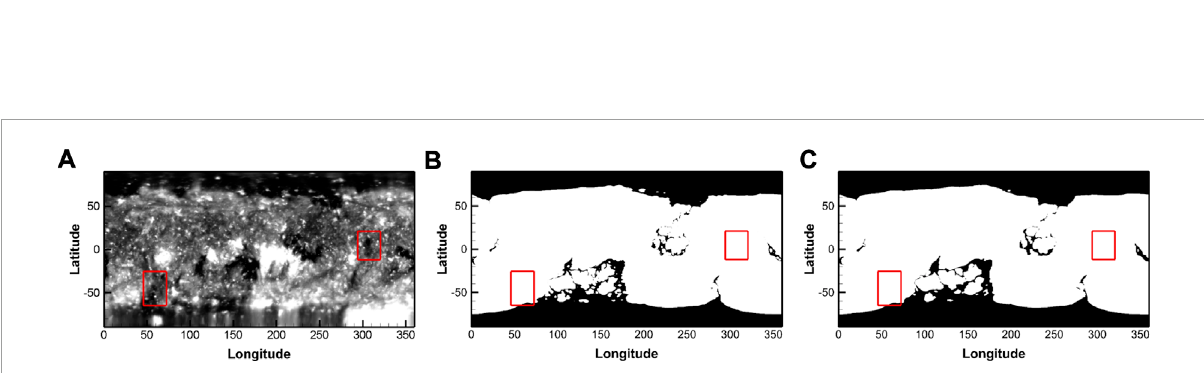
FIGURE 5 Radial magnetic field (Unit: G) at 1 . 8 R s for SHE (black lines), FDIPS (green lines) and DDG-PFSS (magenta lines). The backgrounds are colored with the radial field of the SHE solver. Negative and positive B r are denoted by blue and red color, respectively.